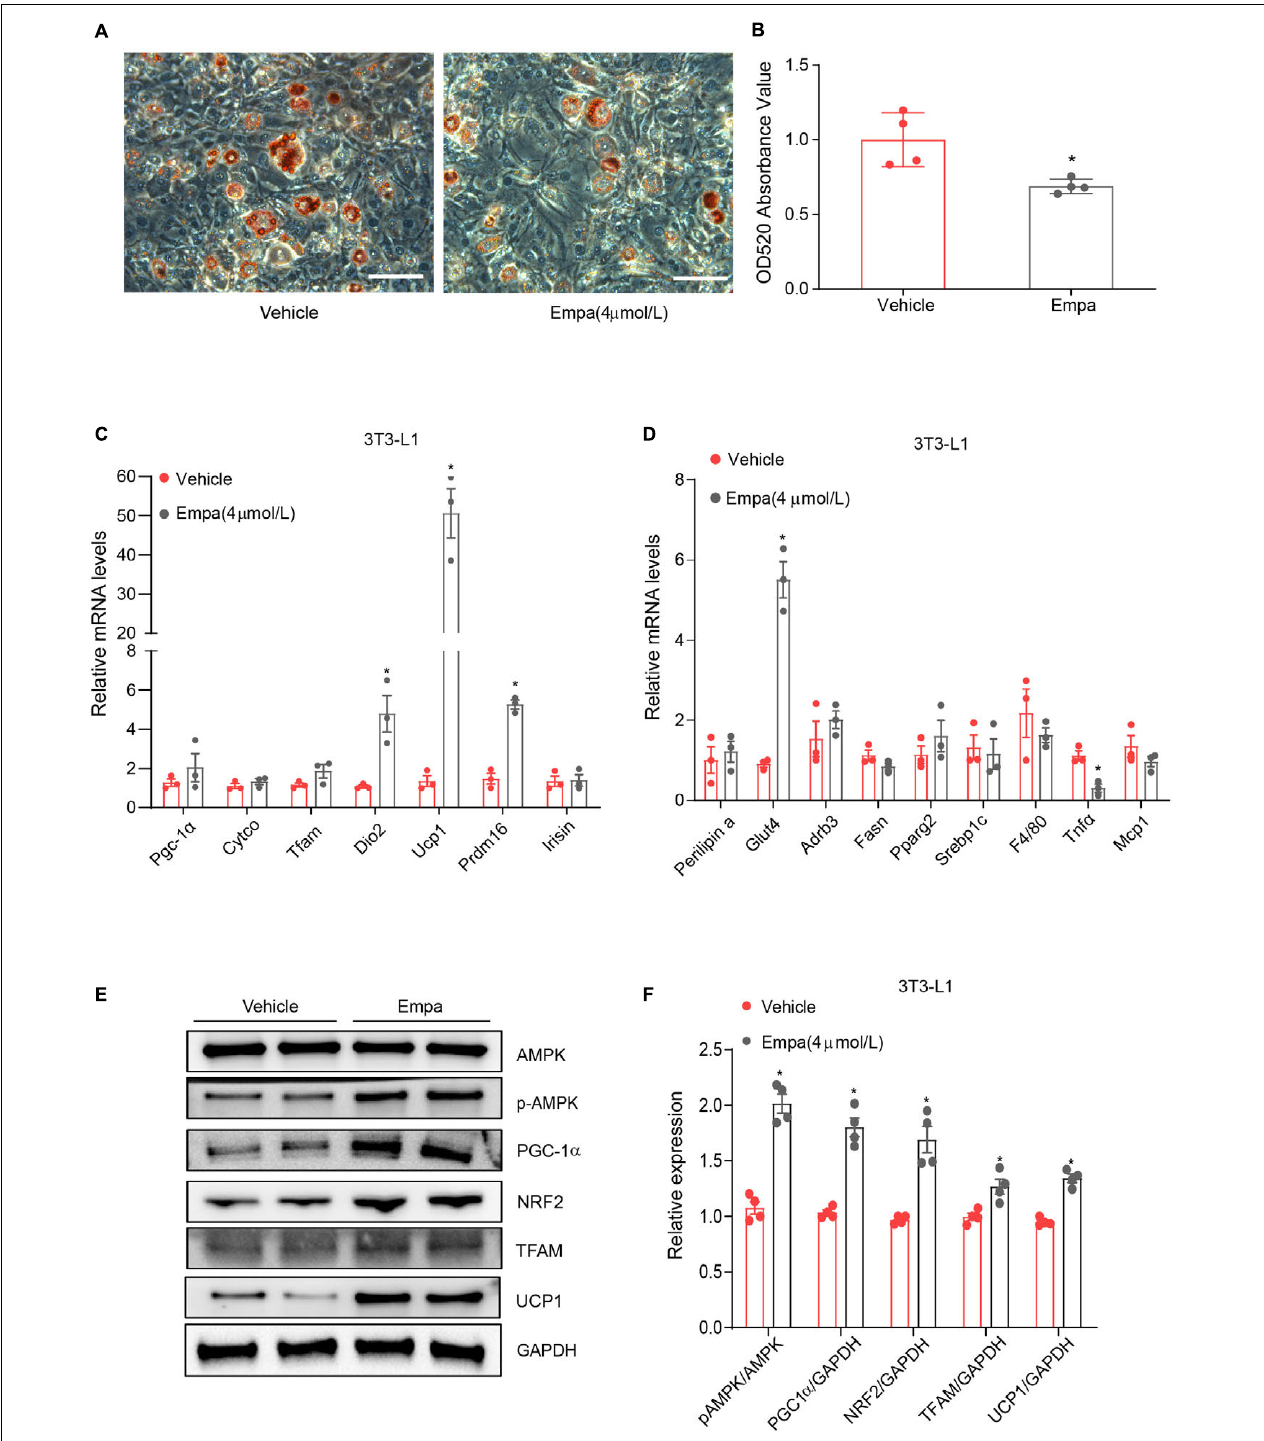
FIGURE 5 | Empagliflozin induces a brown-like phenotype and elevates mitochondrial biogenesis in 3T3-L1 adipocytes. Differentiation of 3T3-L1 preadipocytes was induced through incubation in adipocyte-inducing medium for 5 days and then treatment (Empa) with or without (Vehicle) empagliflozin (4 µ mol/L) in normal culture medium. (A,B) Oil Red O staining and quantification. Scale bar represents 100 µ m. (C,D) qRT-PCR analysis of mRNAs of UCP1 and genes involved in mitochondrial biogenesis ( Pgc-1 α , Cyto c , Tfam , and Dio2 ), thermogenesis ( Prdm16 and Irisin ), lipolysis ( Fasn and Srebf1 ), lipogenesis ( Plin1 , Adrb3 , and Pparg ), and inflammation ( MCP1 , Tnf α , and F4/80 ), with GAPDH serving as a loading control. (E,F) Western blot and quantitation of AMPK, p-AMPK, PGC-1 α , NRF2, TFAM, and UCP-1, with GAPDH used as a loading control. Data are presented as mean ± SEM. * P < 0.05 vs. Vehicle.